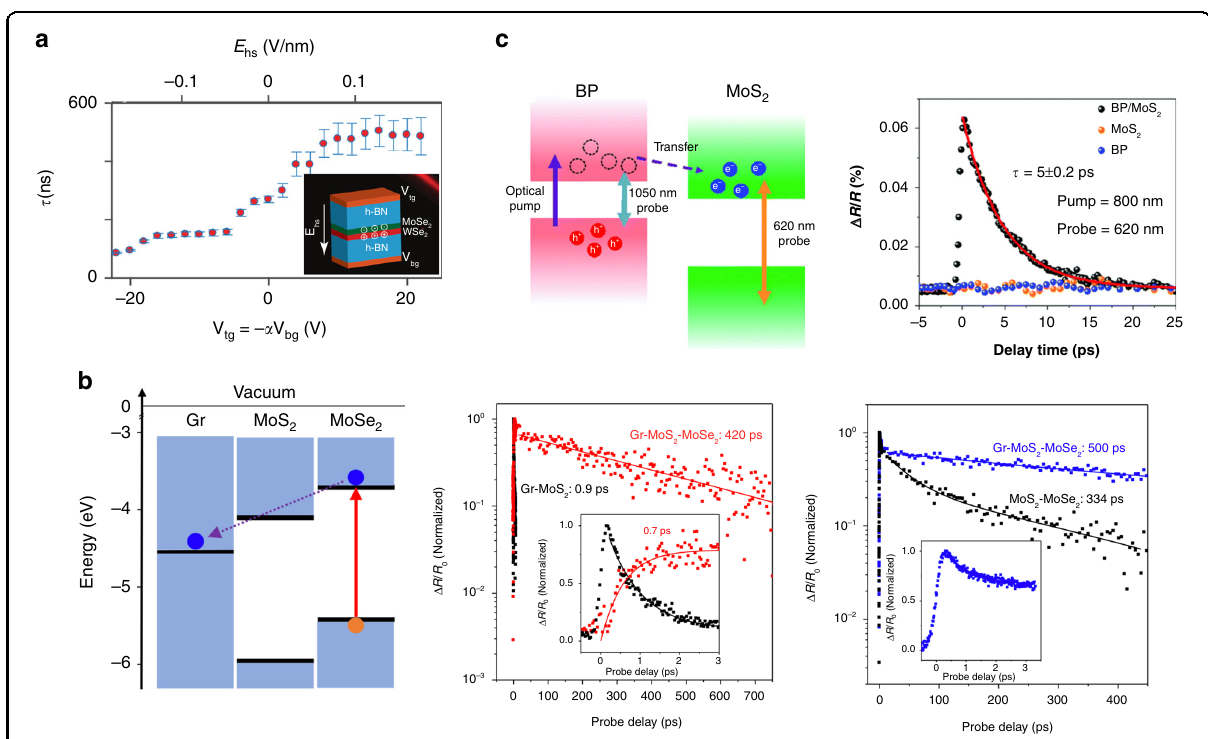
Fig. 7 Photocarrier relaxation in vdW heterostructures. a Interlayer exciton (radiative) lifetime of a MoSe 2 /WSe 2 heterostructure as a function of the electric fi eld applied across the heterostructure. The inset shows a schematic of the heterostructure cross-section. b (Left) Band alignment of the graphene/MoS 2 /MoSe 2 trilayer sample. (Middle) Electron transfer from MoSe 2 to graphene and its lifetime in the trilayer. (Right) Hole dynamics in the trilayer. c (Left) Schematic illustrating the transient processes occurring in a BP/MoS 2 heterostructure under different pump-probe conditions. (Right) Transient re fl ectivity signals of the BP/MoS 2 heterostructure and MoS 2 when pumped at 800 nm and probed at 620 nm, comparing the lifetimes of electrons. Figure reproduced with permission from a ref. 84 , © 2019 AAAS; b ref. 86 , © 2019 Royal Society of Chemistry; c ref. 87 , © 2018 IOP